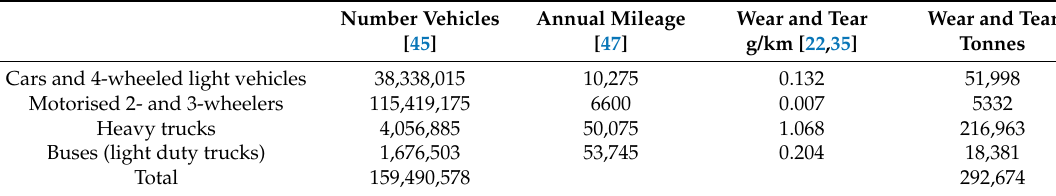
Table 10. Calculation of the amount of tyre wear and tear in India